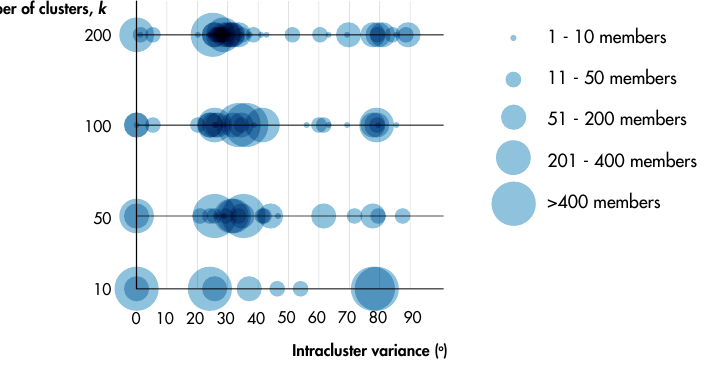
Figure 11. Thesize and intracluster variance of all clusters, when the structure’s joints are subdivided into different numbers of clusters, k .